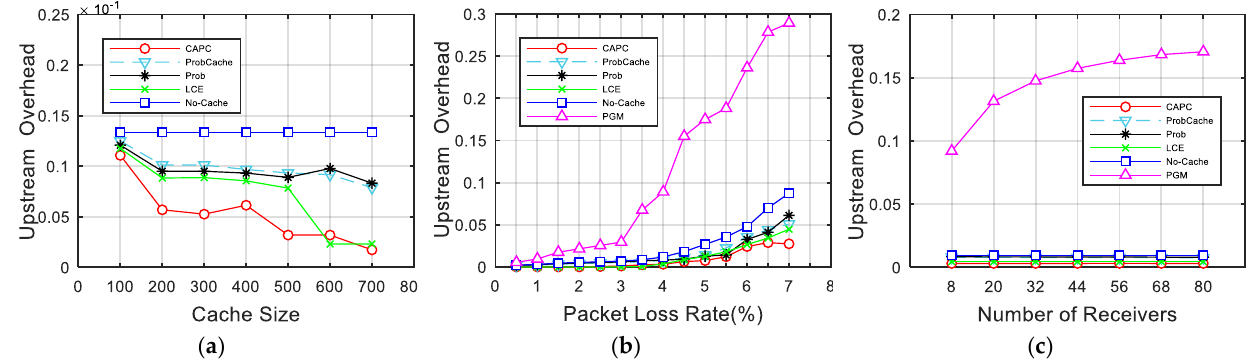
Figure 10. The comparison of upstream overhead. ( a ) The comparison of upstream overhead under different cache sizes; ( b ) the comparison of upstream overhead under different packet loss rates; ( c ) the comparison of upstream overhead under different numbers of receivers.